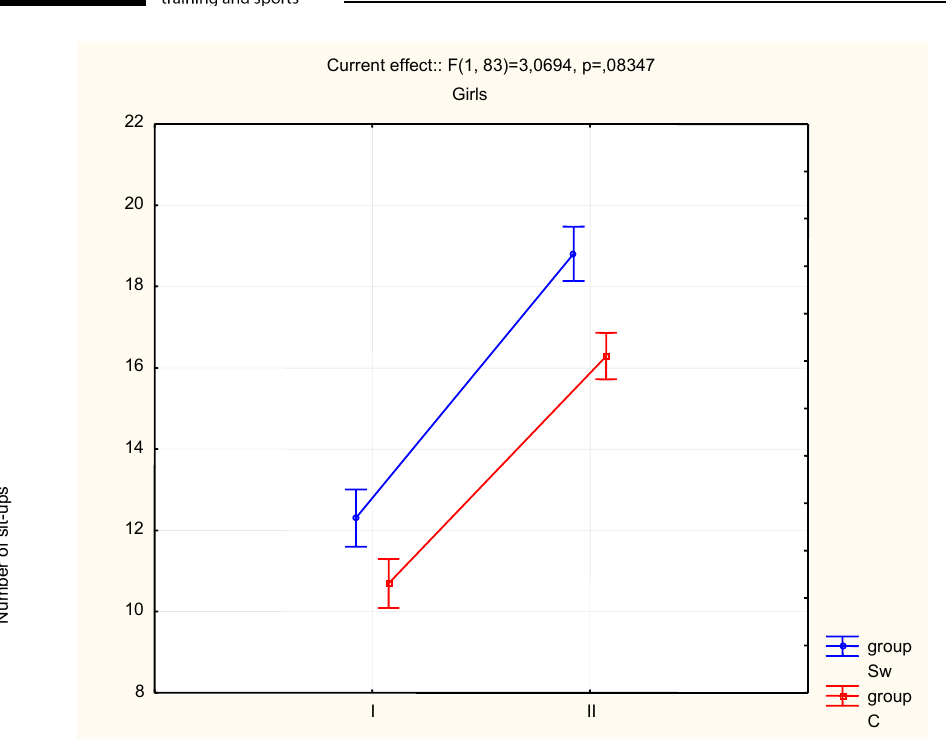
Fig 6. Changes of Sit-Up Test (torso strength) results in the Swimmers (Sw) and Control (C) groups Table 8. Descriptive characteristics of Bent Arm Hang Test (functional strength) results in the Swimmers (Sw) group and Control (C) group